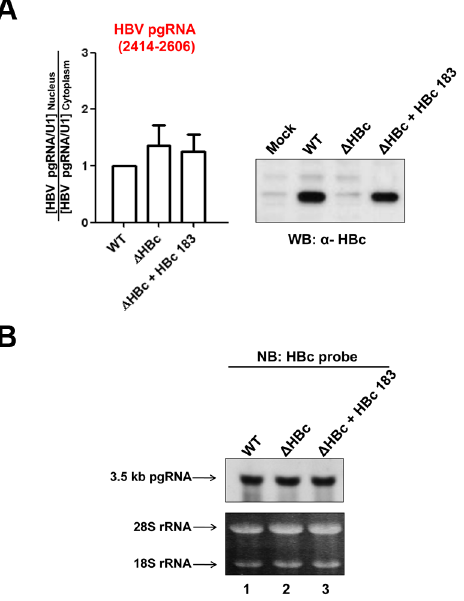
Figure 7. HBV core protein (HBc) exhibited no significant effect on nuclear export of the 3.5 kb pgRNA. A) HuH-7 cells were transfected with various plasmids of HBV genomes (based on plasmid pCHT-9/3091), containing wild type (WT) HBc, mutant D HBc (a core- deficient HBV genome), and a combination of D HBc and an expression vector of full-length HBc 183, respectively. HBV RNAs were extracted from nuclear and cytoplasmic compartments according to the Vendor’s protocol (Materials and Methods). Plasmid D HBc resulted in no apparent effect on the relative distribution of HBV pgRNA levels between nucleus and cytoplasm (N/C) by RT-qPCR analysis. The N/C Figure 8. Interference with the NXF1-p15 complex reduced